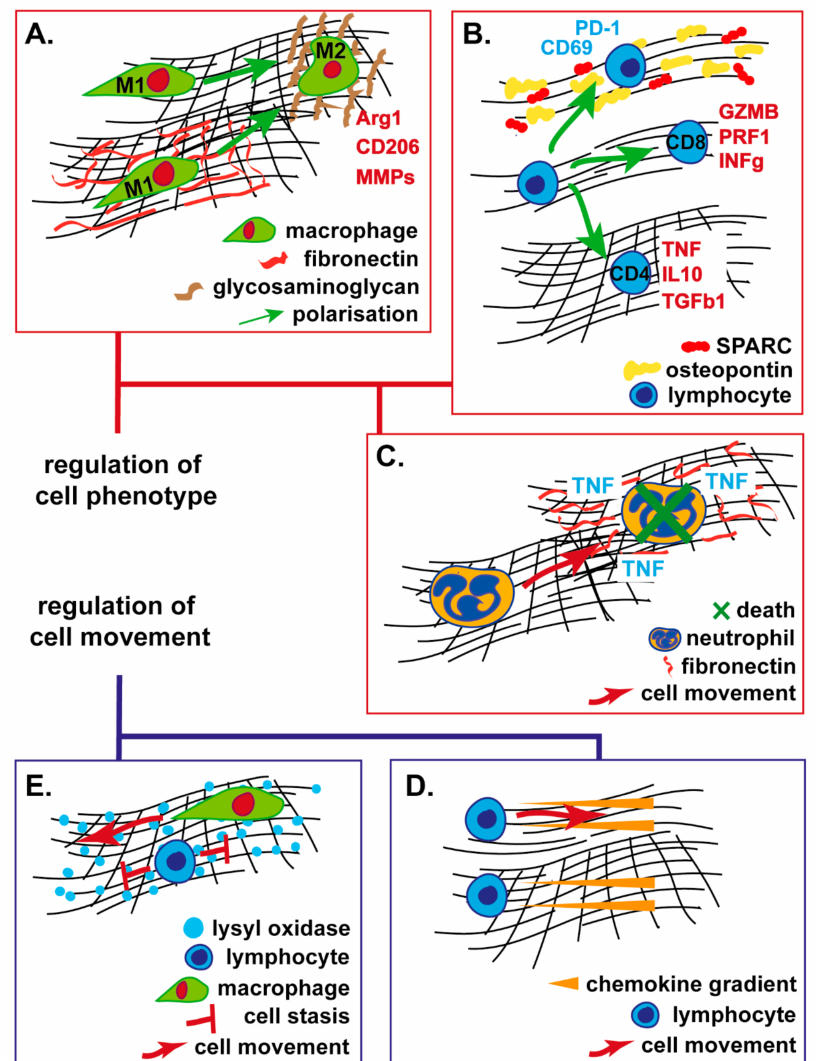
Figure 2. Proposed mechanisms though which the tumour ECM modulates immune cell phenotype and movement (see text for further details). ( A ) Macrophages in dense matrices demonstrate alternative states of activation dependent on the presence of various ECM glycoproteins. ( B ) T-lymphocyte phenotype is dependent upon collagen fibre density with loose matrices supporting cytotoxic T-lymphocytes but densematricesorthoseincorporatingspecificglycoproteinsleadingtoimmune-inhibitoryphenotypes. ( C ) Neutrophil survival and cytokine production is dependent upon the presence of specific ECM glycoproteins. ( D ) T-lymphocyte movement is driven by chemokine gradients in loose ECM, but in dense ECMs, T-lymphocytes to not demonstrate chemokine-directed movement. ( E ) Cancer ECM structure may di ff erentiallymodulatethemigrationofT-lymphocytesandmacrophages, withonlymacrophagesableto move in dense, highly cross-linked matrices. Collagen fibre matrices demonstrated in black with degrees of density or cross-linking indicated. Arg Arginase, MMP matrix metalloproteinase, GZM granzyme, PRFperforin, INFinterferon, TNFtumournecrosisfactor, ILinterleukin, TGFtransforminggrowthfactor, SPARC Secreted Protein Acidic and Rich in